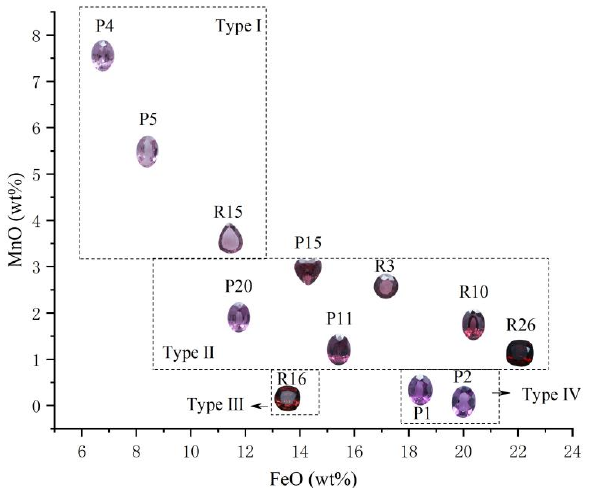
Figure 6. The color of pyrope-almandine is related to their chemical composition. The trend of color is comprehensive due to the complex action mode of Mn 2+ . There are typical 12 samples of both color and chemical composition that illustrate the color cause clearly. Table 5. The absorption characters, chemical contents, and color causes of four types garnet which result in the trend of color